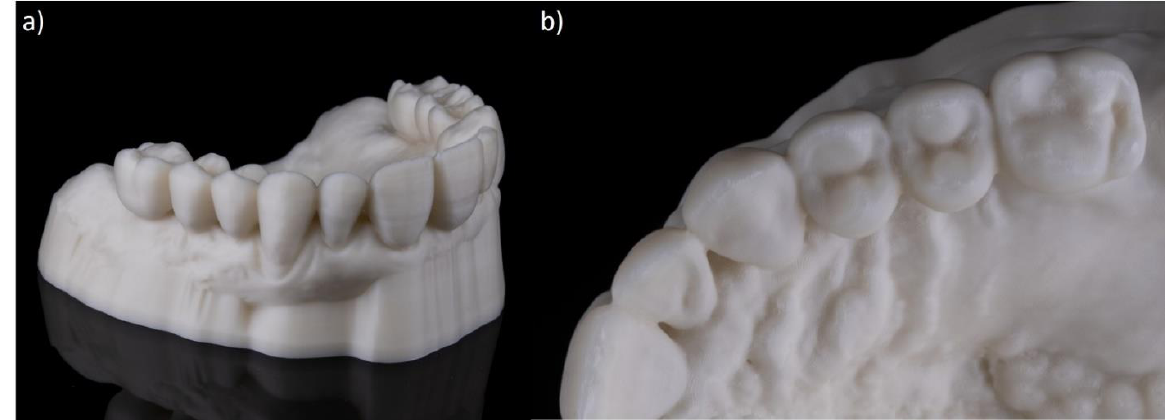
Figure 1. ( a ) Dental model of the upper jaw manufactured by fused filament fabrication (FFF), ( b ) Detailed view of highly accurate tooth structures.